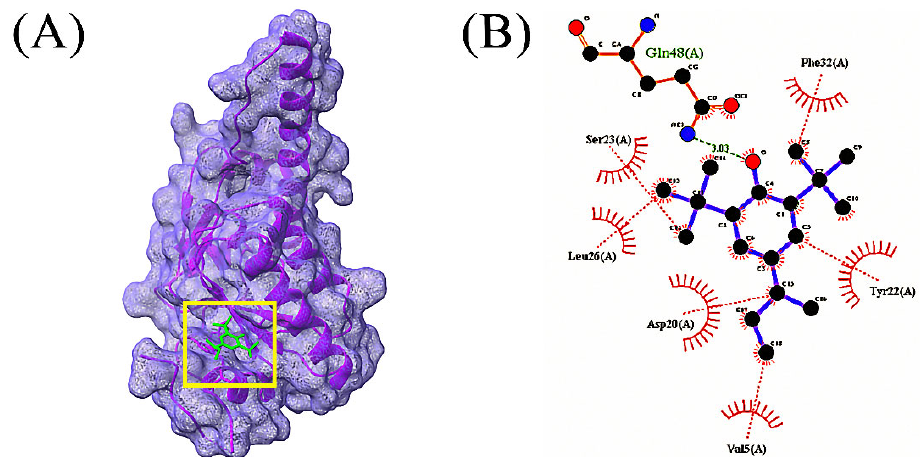
Figure 6. Docking simulation between protein-ligand interactions of caseinolytic proteases (Clp) enzymes Bacillus subtilis (PDB ID: 7M1M) and bis(pentamethylcyclotrisiloxy)tetramethyldisiloxane,